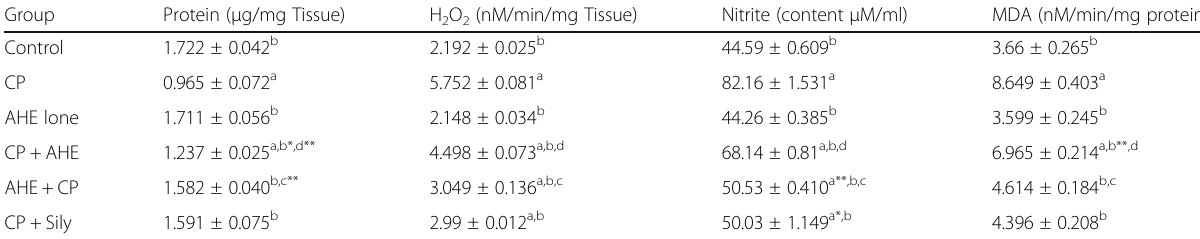
Table 3 Effect of cisplatin (CP) and different treatments of AHE on lung tissue protein, oxidative stress markers and lipid peroxidation